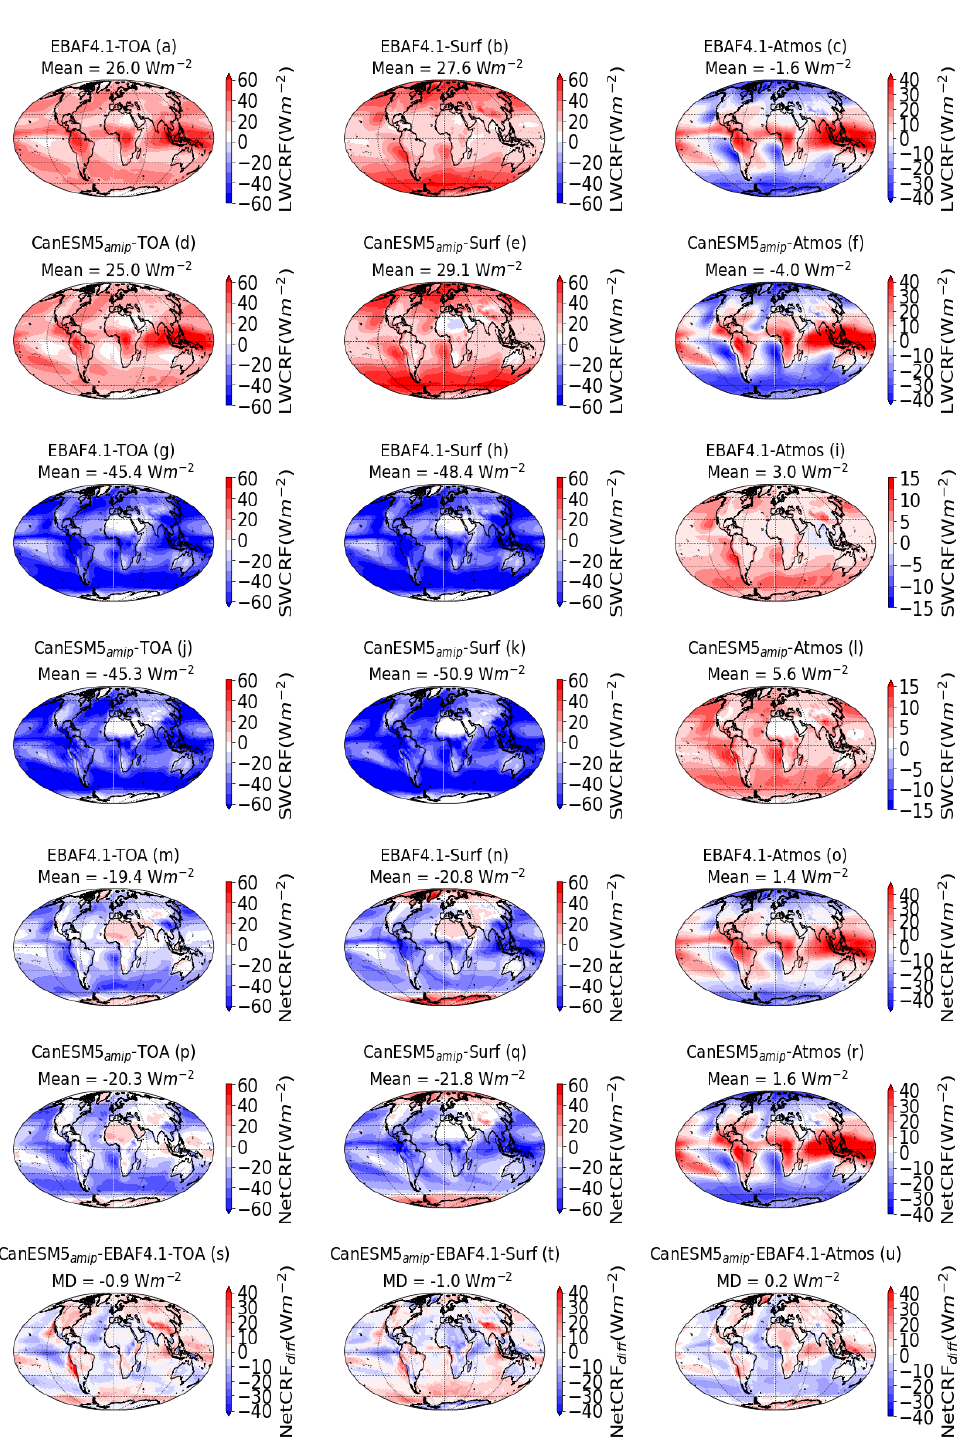
Figure 13. The annually averaged global distributions of SWCRF, LWCRF, and NetCRF at the TOA, surface, and in the atmosphere derived based on the satellite (EBAF4.1) and CanESM5 model data. In contrast to the LWCF, the SWCF at the TOA and surface is negative (cooling) with global means values of − 45.4 and − 48.4 Wm − 2 , respectively. The spatial distribution of the SWCRF at the TOA and surface is largely connected to variation in cloud cover